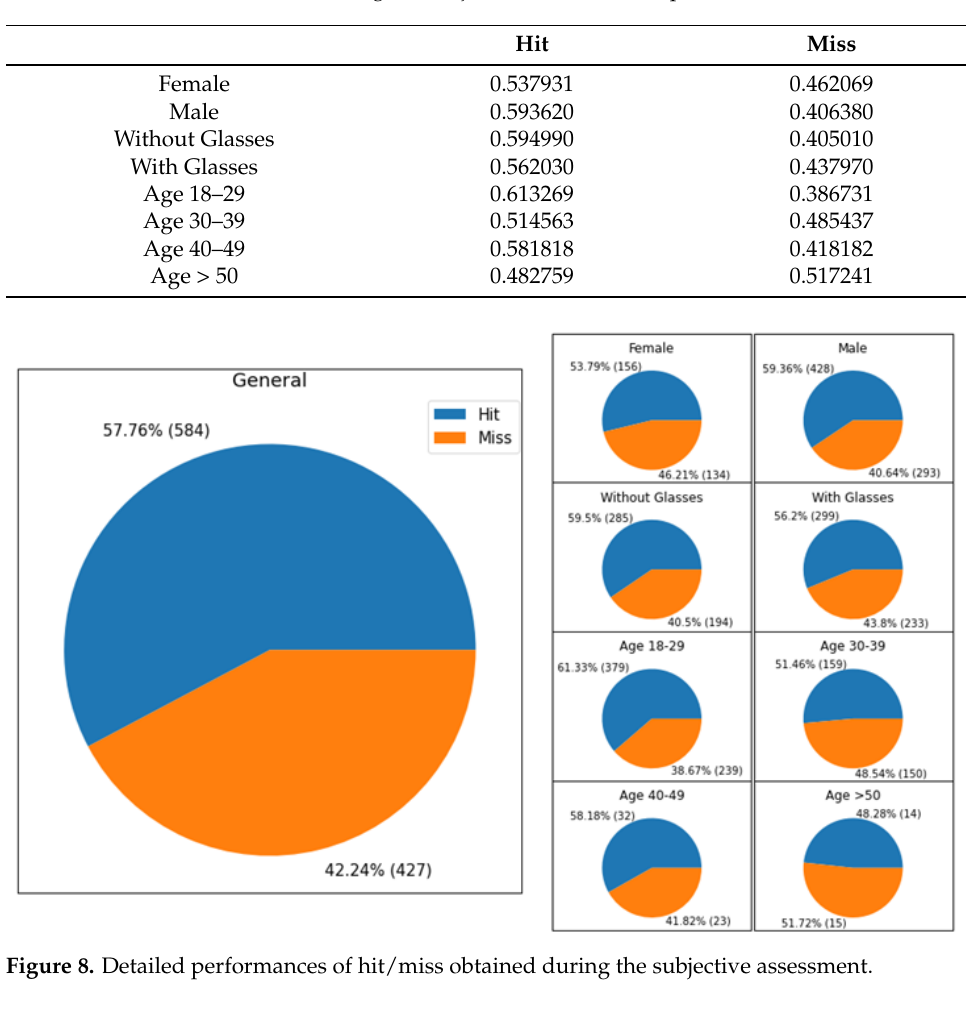
Table 8. Hit and miss collected during the subjective assessment experiments.